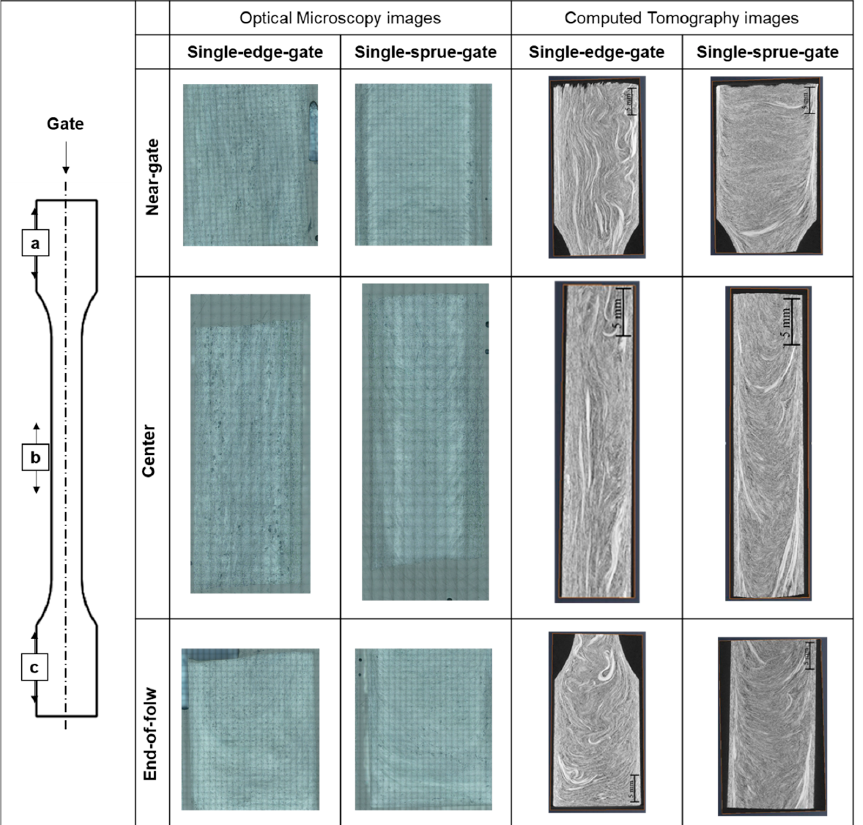
Figure 6. Observation of optical microscopy and computed tomography images (core layer) for different melt flow paths: ( a ) the near-gate region, ( b ) the center region, and ( c ) the end-of-flow region.